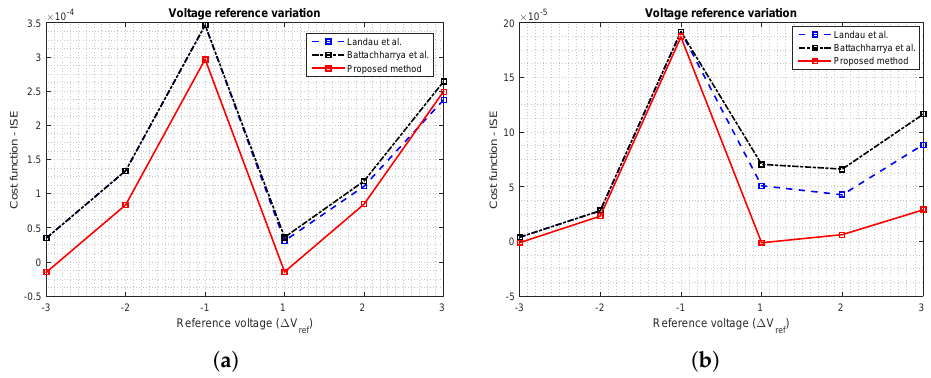
Figure 18. Cost function ISE when occurs the voltage setpoint variation. ( a ) Simulation and ( b ) Experimental